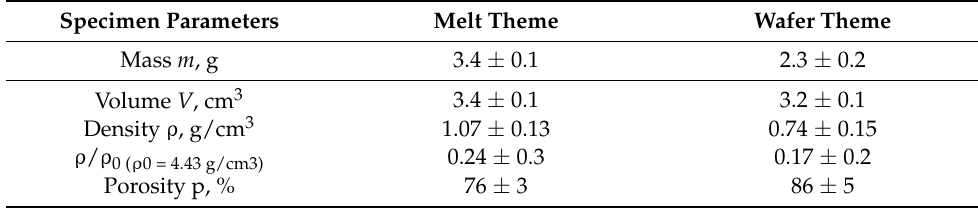
Table 1. Specimen